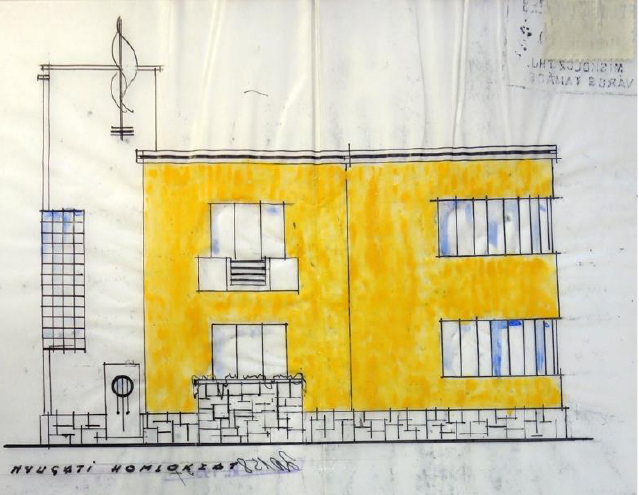
Figure 11. 1 Jen ő Farkas street. Architect: Victor Bohm, 1937. Source: MNL BAZML IV. 1906/b. Figure 11. 1 Jen˝o Farkas street. Architect: Victor Bohm, 1937. Source: MNL BAZML IV. 1906/b. 2701/1938.